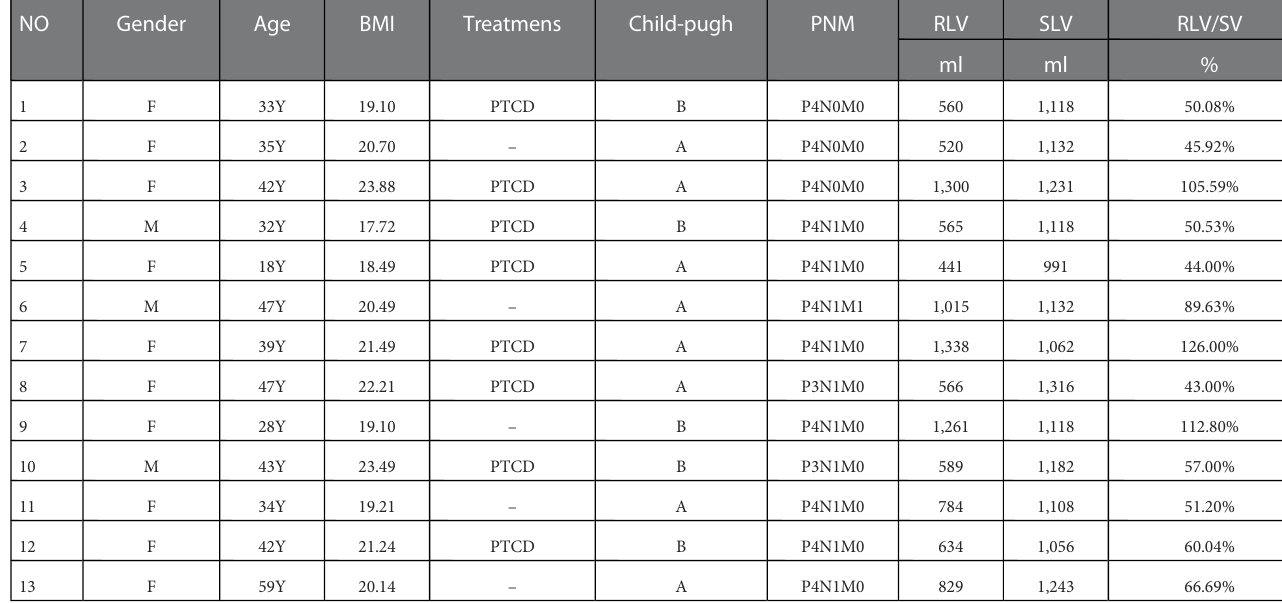
TABLE 2 Clinical data and preoperative evaluation of 13 patients with advanced hepatic alveolar echinococcosis.